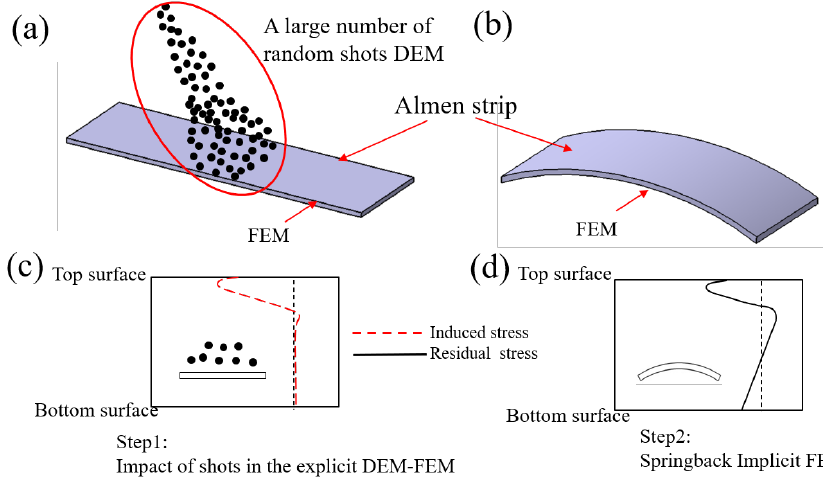
Figure 5. Improved DEM-FEM method. ( a ) Impact of shots in the explicit DEM-FEM. ( b ) Springback Implicit FEM. ( c ) Induced stress profile. ( d ) Residual stress profile.